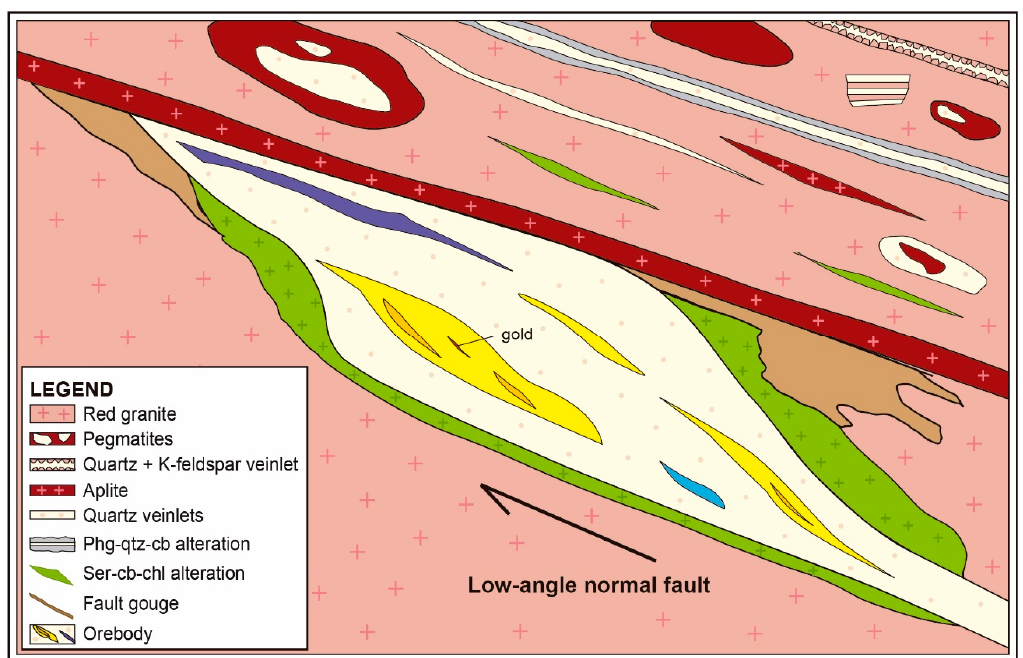
Figure 21. Schematic drawing showing the distribution of the different alteration styles related to the gold mineralisation, Passa Três granite, Barreiro zone. Abbreviations: Cb—carbonate; Chl—chlorite; Phg—phengite; Qtz—quartz; Ser—sericite. Not to scale.